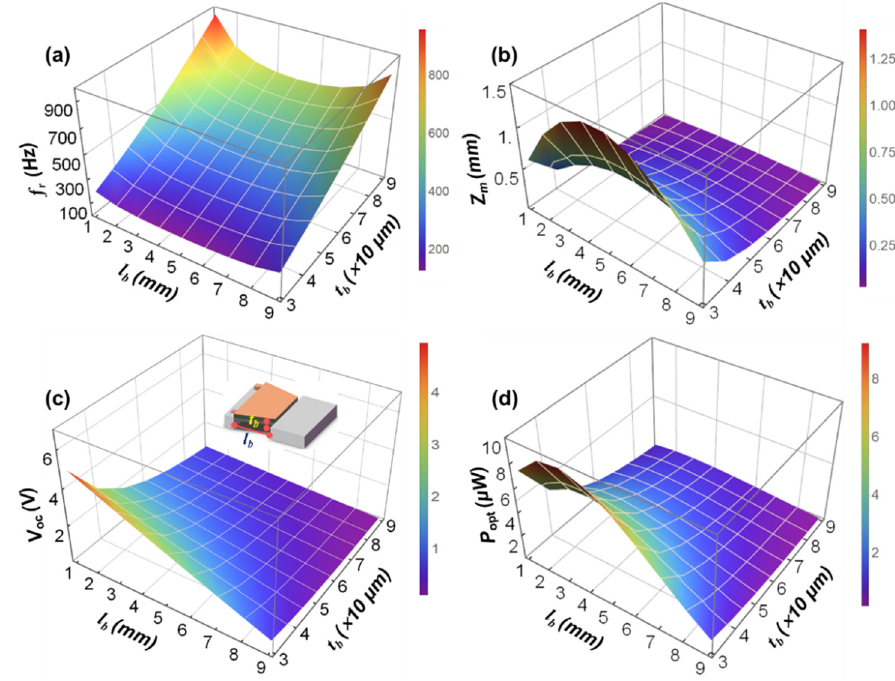
f ( a ), the maximum displacement of the tip mass r V ( c ), and the optimal load output power P ( d ) of the MEMS oc opt l and t . b b